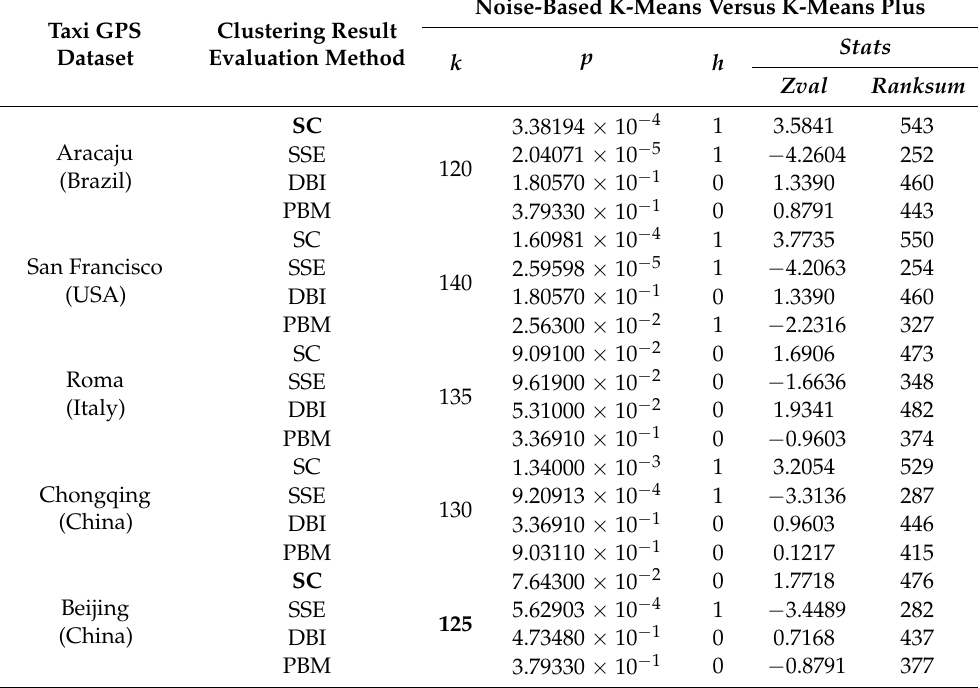
Table 10. Statistical analysis results of Wilcoxon testing for noise-based K-means vs. K-means